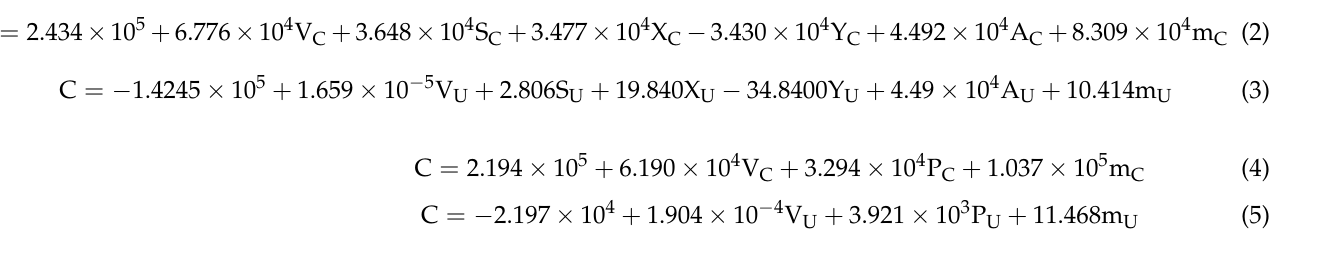
Table 5. Significant MT features from stepwise regression.